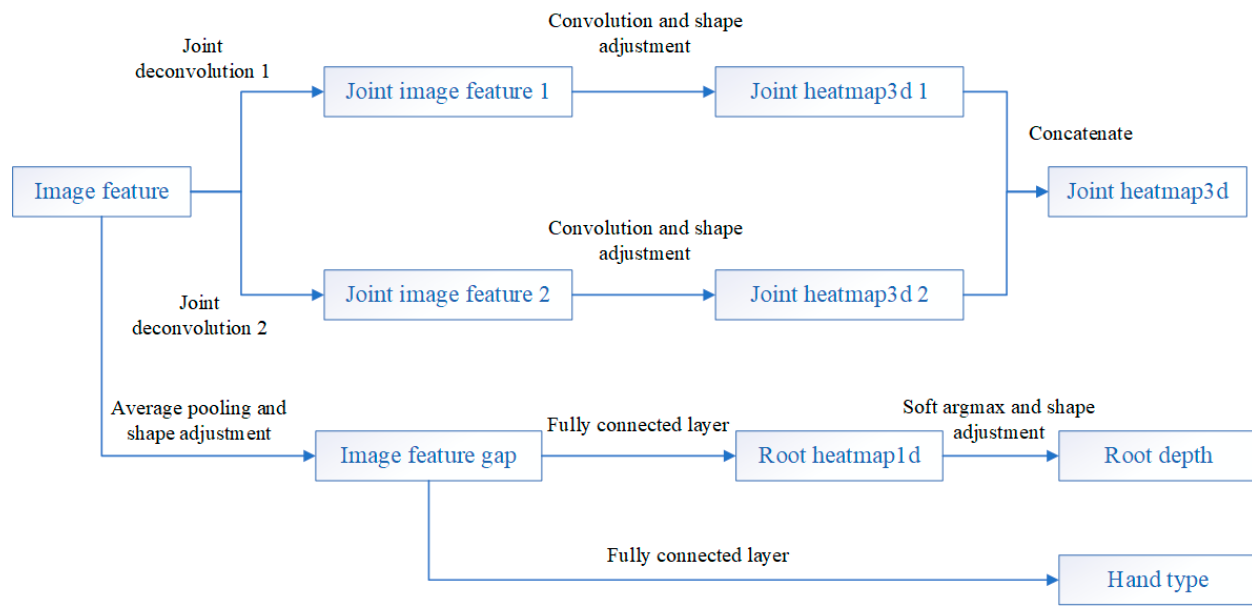
Figure 2. Specific structure with the input and outputs of PoseNet (feature processing network in Figure 1) is displayed. “Image feature” is the feature map obtained in the feature extraction network, “Joint heatmap3d” is the heatmap of the estimated key-points’ position of the hand in a 3D pose, “Root depth” is the root point related depth of two hands, and “Hand type” is the judged hand type (left or right).